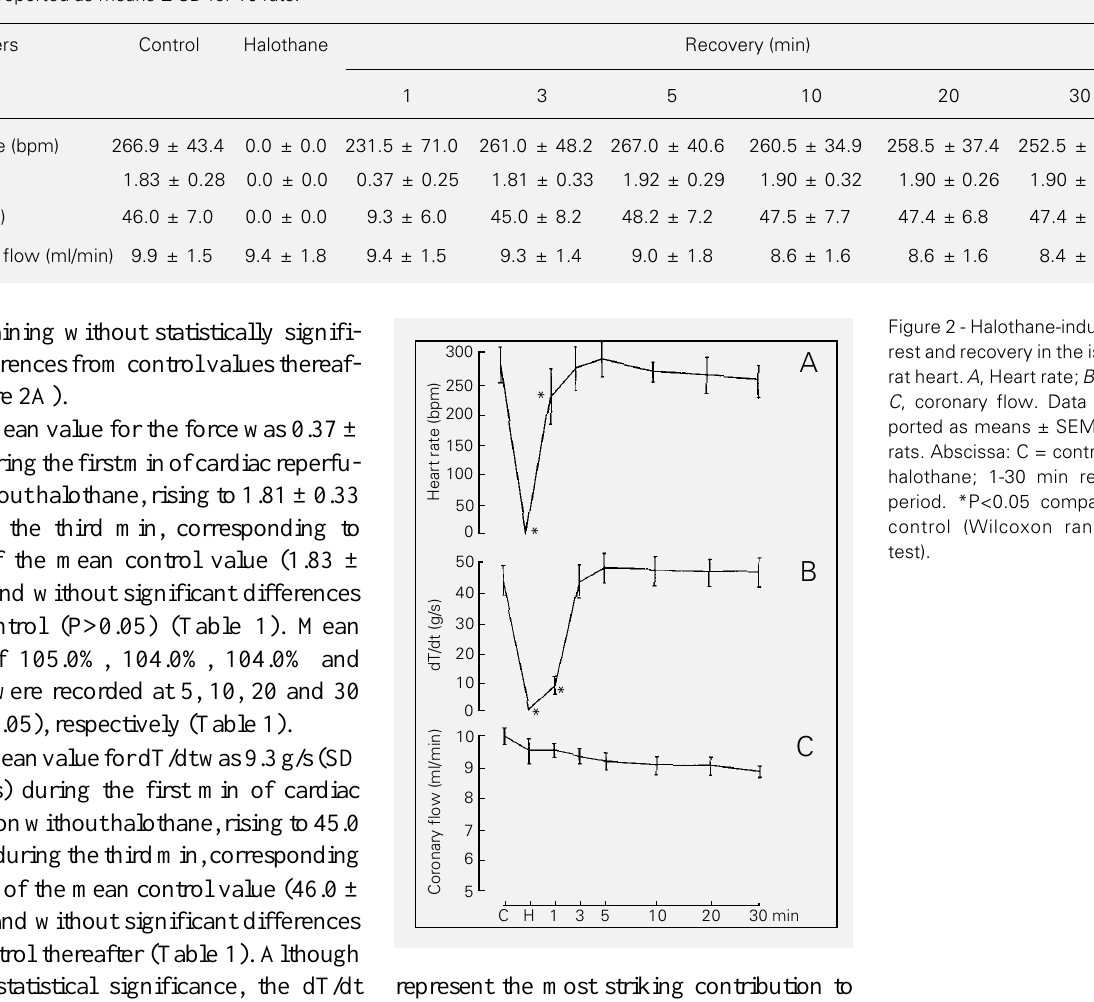
Table 1 - Halothane-induced arrest and recovery of isolated rat hearts. Data are reported as means ± SD for 10 rats.